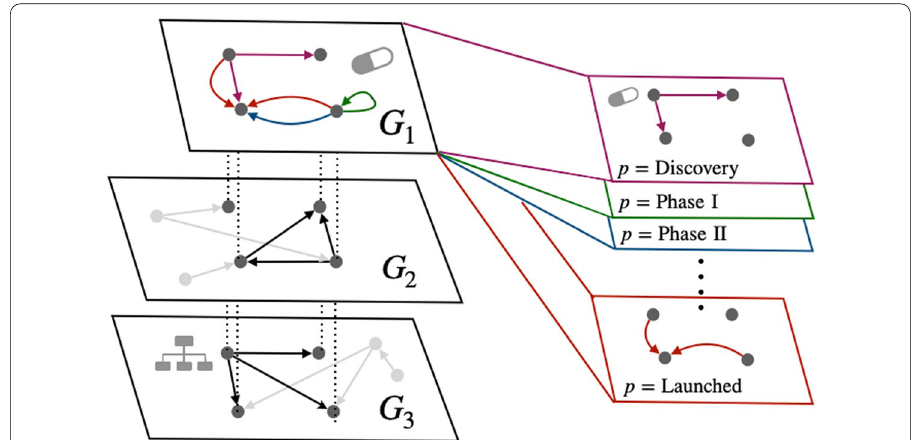
Fig. 4 Overview of the MLN representation. We used the drug pipeline, supply chain, and ownership data to define the MLN ( M = 3 ), which is composed of firms and institutions as nodes. Then, we construct MLN for knowledge flow based on the edge attribution about the status of the drug